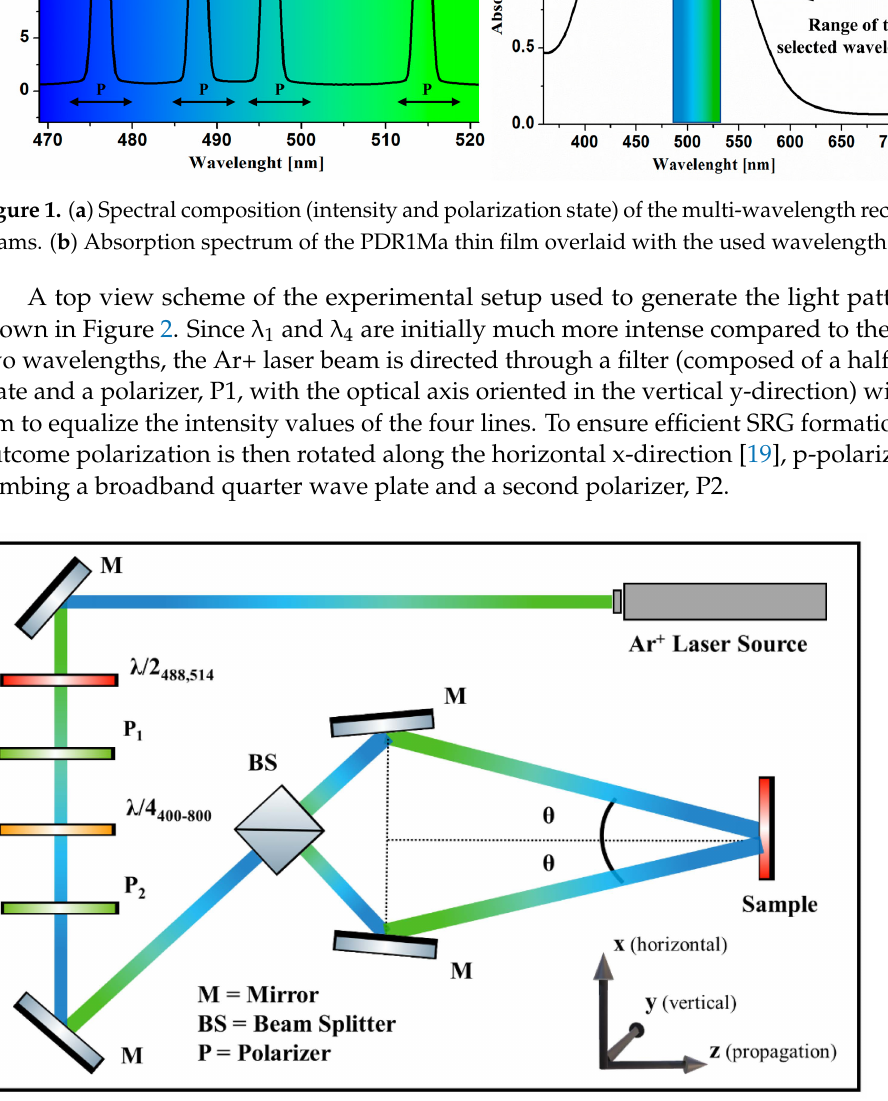
Figure 2. Top view (xz plane) scheme of the experimental setup in the xyz laboratory frame. After the above manipulation, the beam is split into two equal intensity beams by a non-polarizing cube beam splitter and directed towards the sample. The two multiline beams cross at a small angle ( θ ~4.5 ◦ ) with the z -axis (propagation direction) and generate the light pattern in the xy plane at the overlapping position. The sample is exposed to the resulting interference figure for 15 min setting each beam power at 10